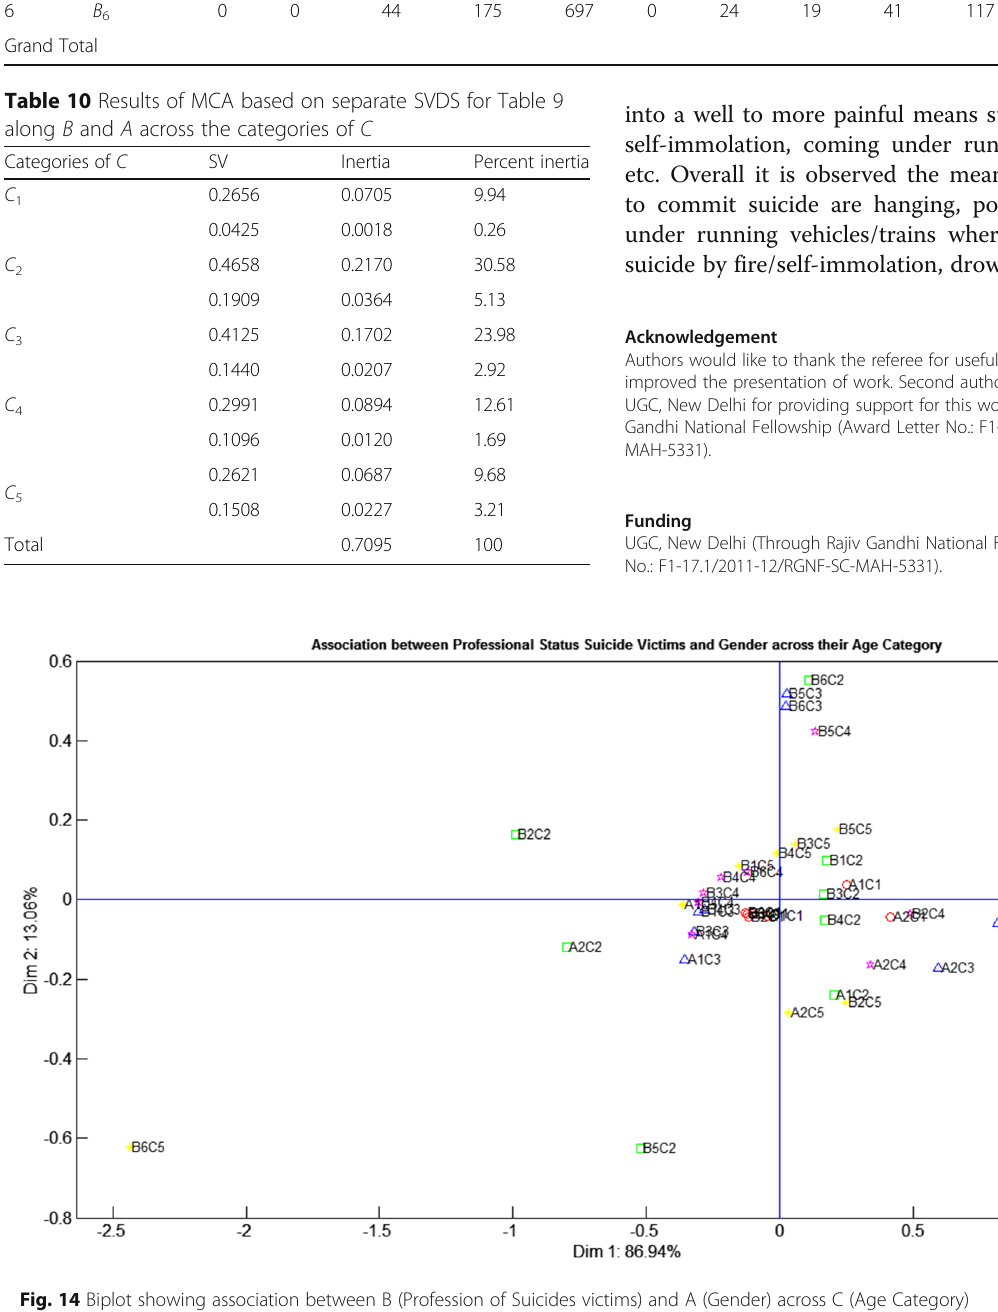
Fig. 14 Biplot showing association between B (Profession of Suicides victims) and A (Gender) across C (Age